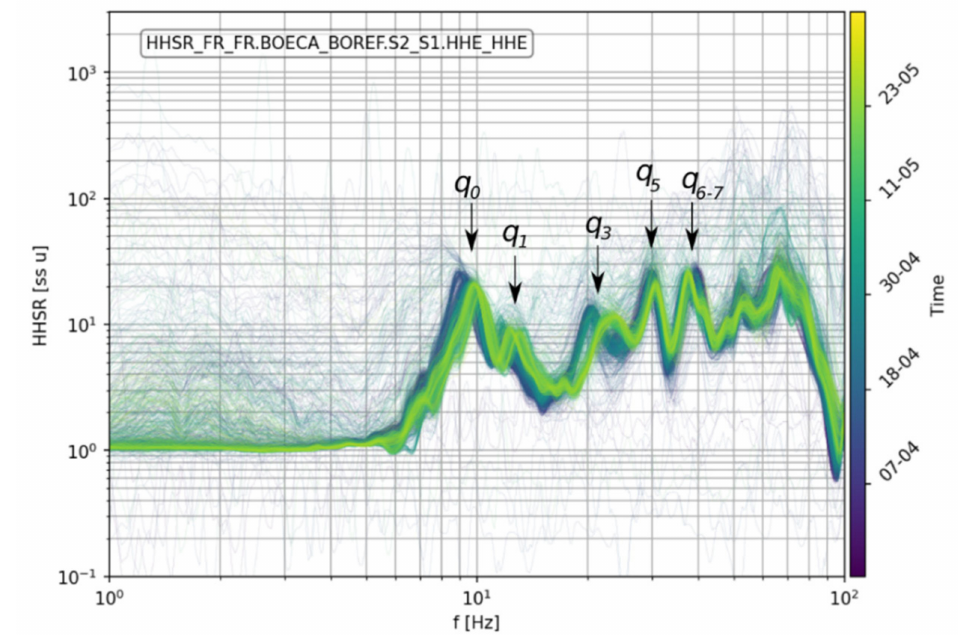
Figure 7. HHSR of 1 h segments for BOECA/BOREF sensors, for the east component. The color scales with time during the monitoring period (from dark blue to yellow, see color bar). Clear HHSR peaks q 0 –q 6–7 are shown with vertical